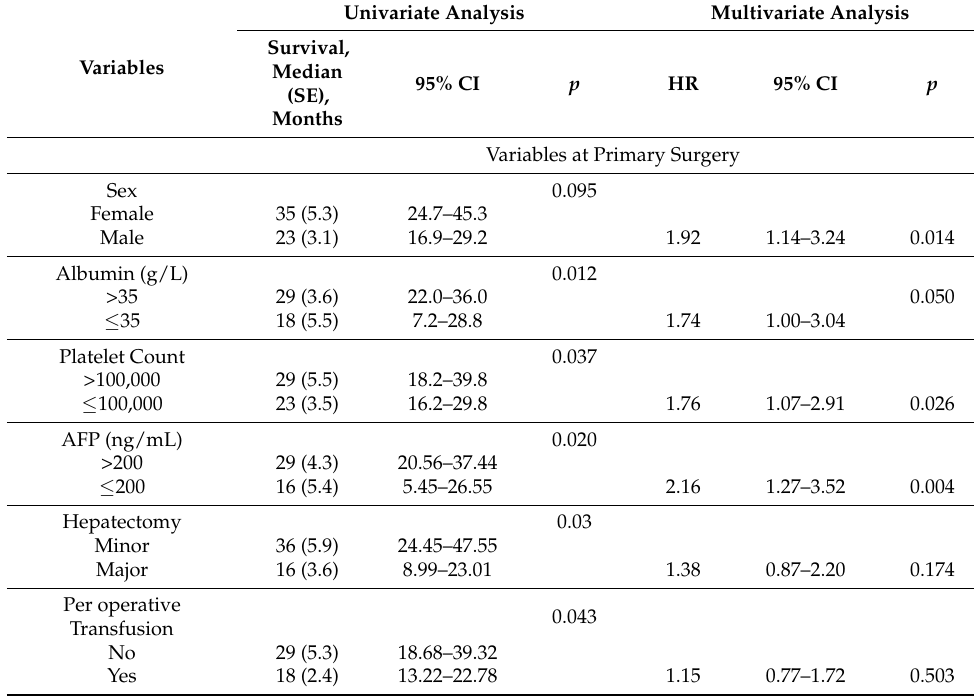
Table 2. Univariate and multivariate analyses to predict survival after recurrence.